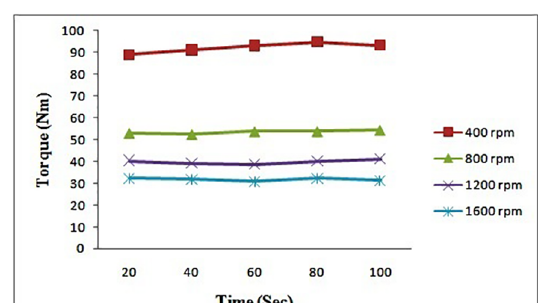
Figure 6 . Torque on the welds with water head of 20 mm and rotational speed rates of 400, 800, 1200 and 1600